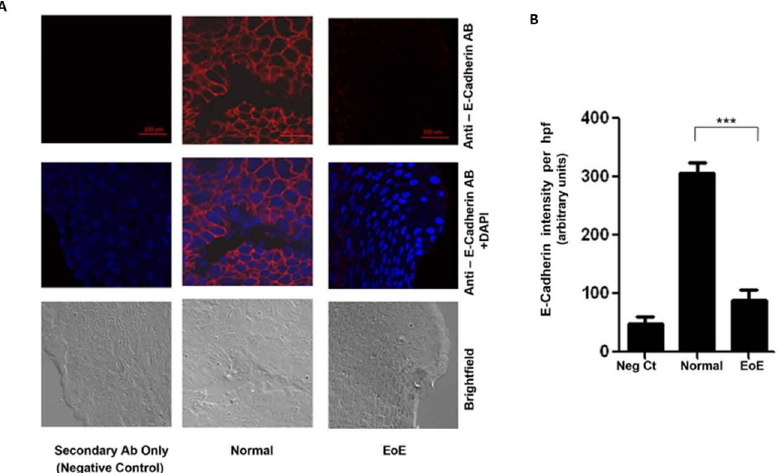
Fig 3. Densitometric analysis of: A. Zonula Occludens-1 and B. E-cadherin. Values are representative of the mean of a sample size of 18 control and 18 patients with EoE. ��� P < 0.001.